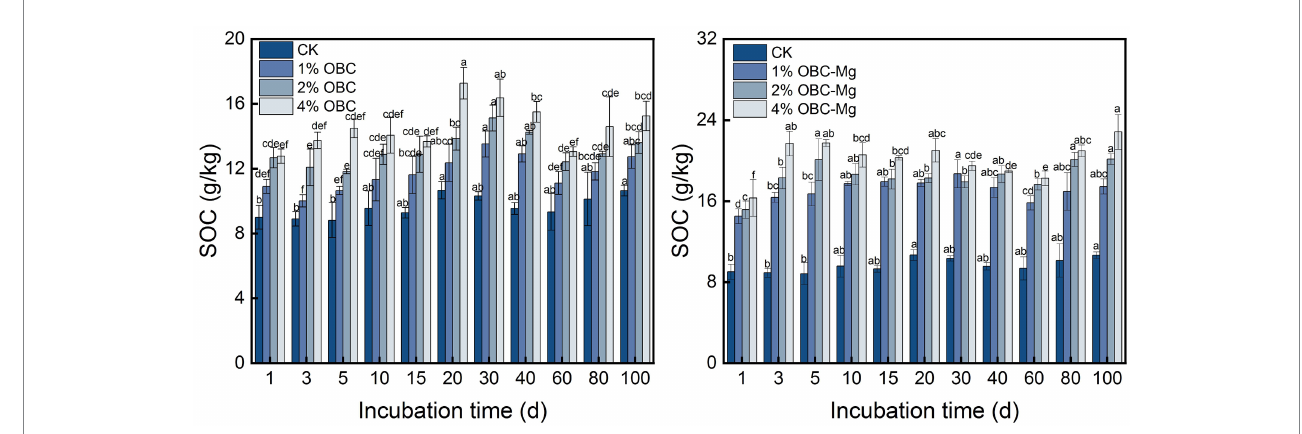
FIGURE 8 Changes in soil organic carbon (SOC) after the amendment of OBC and OBC-Mg.